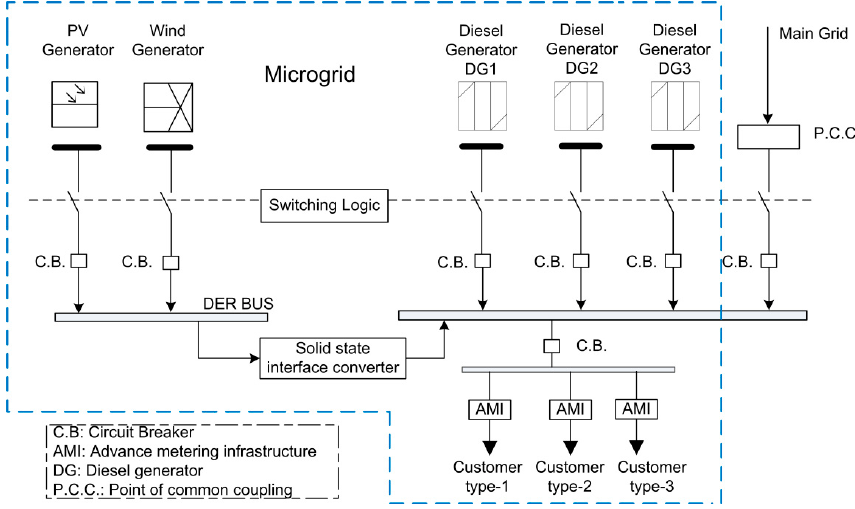
Figure 1. Schematic: grid-integrated microgrid.